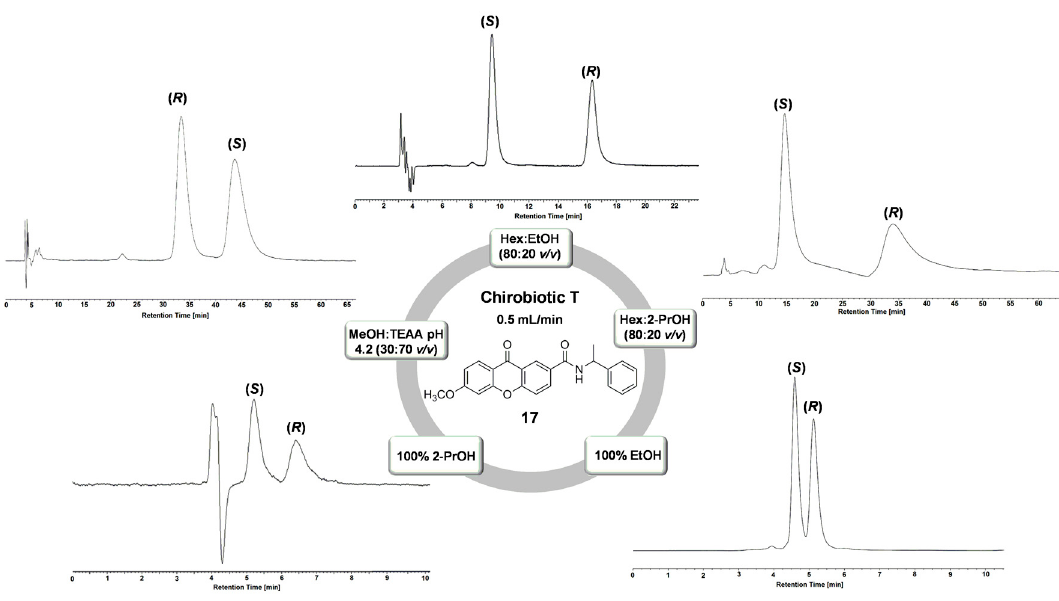
Figure 3. Chromatograms of the enantioseparation of analyte 17 on the Chirobiotic TM T column using different mobile phases.